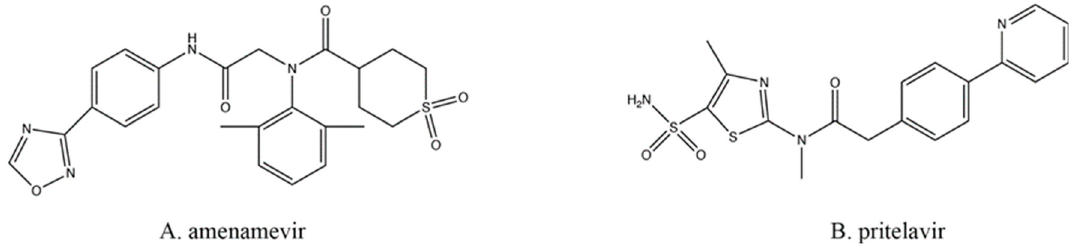
Figure 4. Helicase–primase inhibitors.